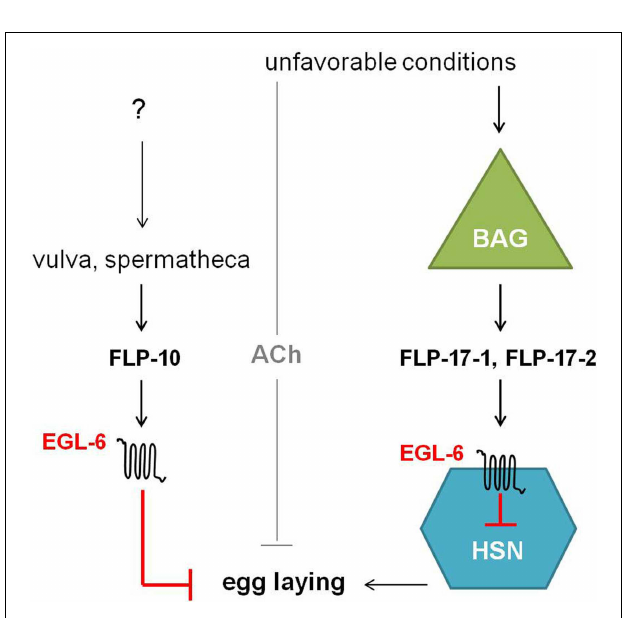
FIGURE 7 | Unfavorable conditions cause the release of FLP-17 neuropeptides from BAG neurons. These neurohormones activate EGL-6 in HSN neurons in order to inhibit egg-laying. Release of FLP-10 by the vulva and spermatheca along with subsequent signaling via EGL-6 also inhibits egg-laying. How parts of the hermaphrodite’s reproductive system might inhibit egg-laying is not yet fully understood. In parallel to peptidergic inhibition, cholinergic signals inhibit egg-laying upon unfavorable conditions (Ringstad and Horvitz, 2008).